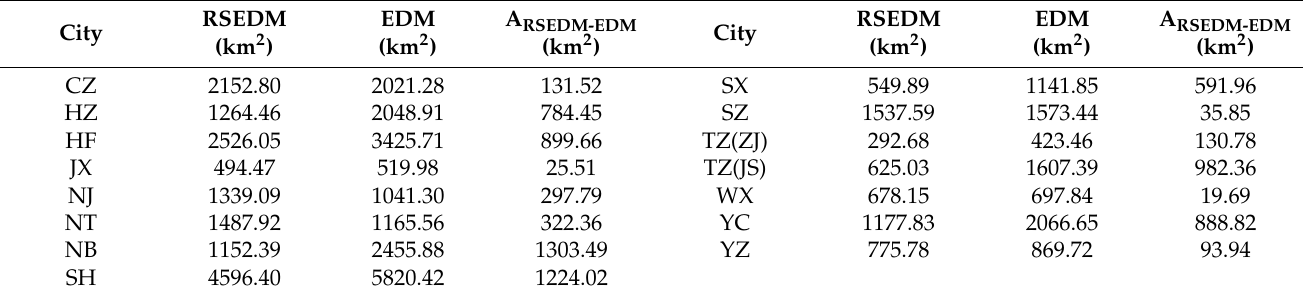
Table 2. Footprint area of rotational-scan exponential decay model and exponential decay model of 15 cities. A RSEDM-EDM are the absolute terms of the difference between the two methods.